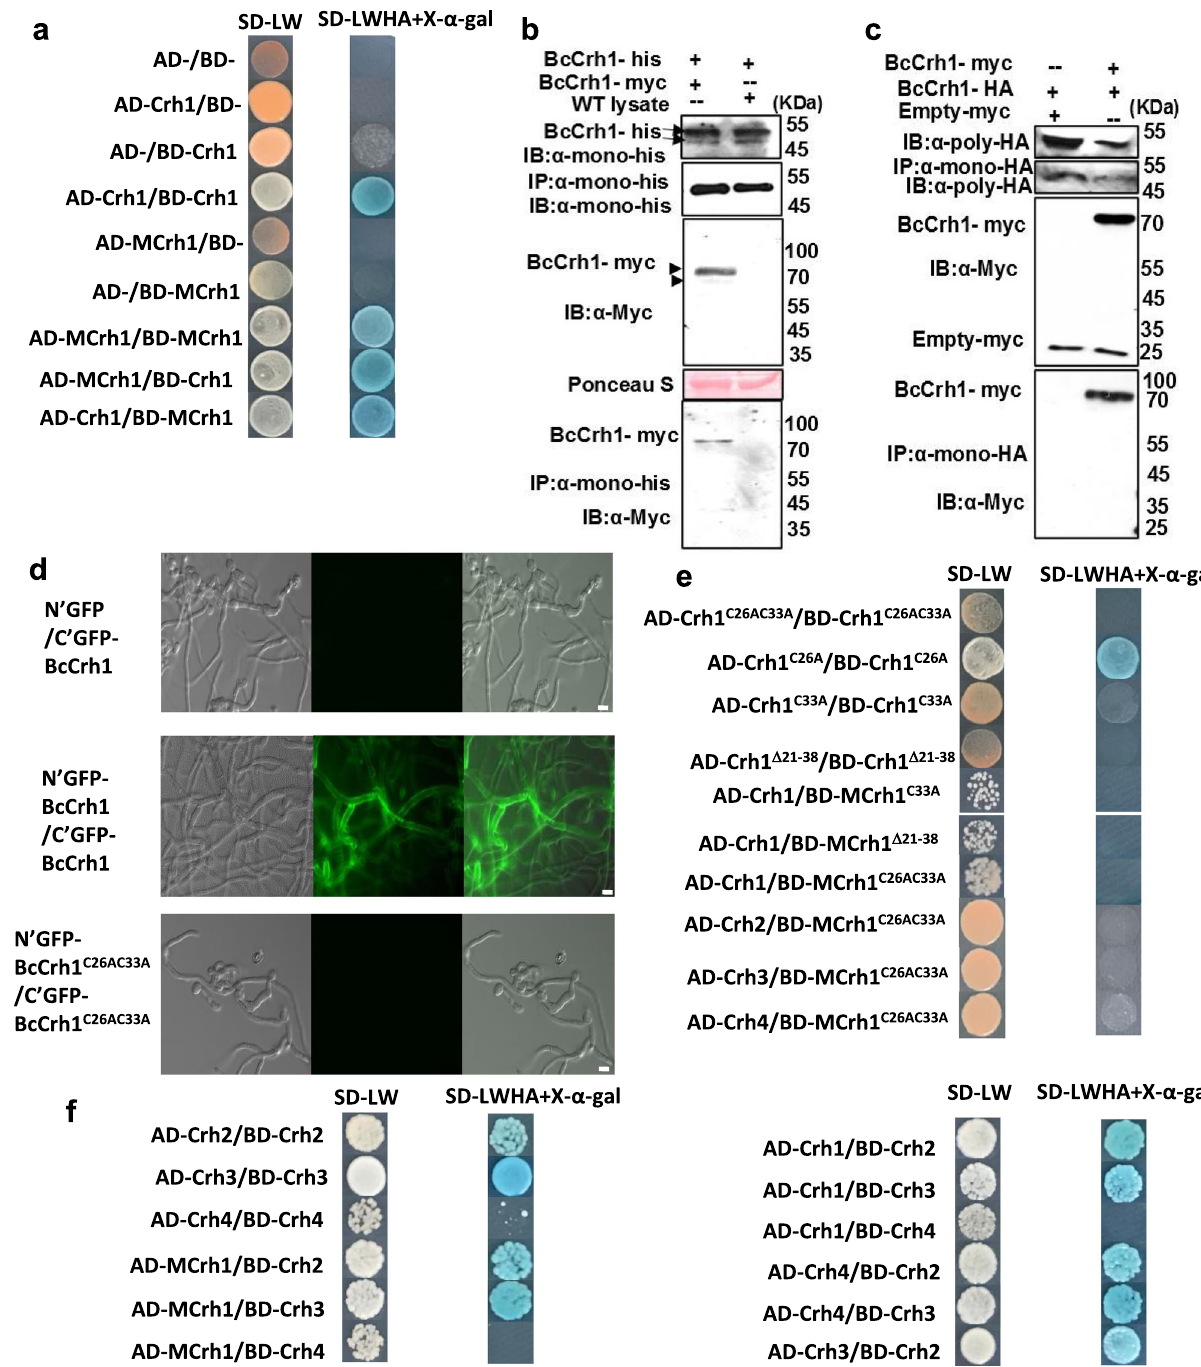
Fig. 8 BcCrh protein dimerization. a Yeast two-hybrid assay (Y2H) of BcCrh1 and MBcCrh1 homodimer formation. SD/-Trp-Leu medium was used to con fi rm the transformation events. SD/-Trp-Leu-His-Ade medium containing X- α -gal was used to screen yeast strains with the positive protein-protein interaction. b – d Con fi rmation of BcCrh1 dimer formation by in vitro pull down assay ( b ), Co-immunoprecipitation (Co-IP) assay ( c ) and bimolecular fl uorescence complementation (BiFC) assay ( d ). b For the in vitro pull-down assay, BcCrh1-myc was transiently expressed in N. benthamiana and pull down was performed with BcCrh1-His recombinant protein conjugated with histidine beads. Protein from non-in fi ltrated leaves (WT lysate) was used as negative control. c For the Co-IP experiment, BcCrh1-myc or empty-myc were co-expressed with the BcCrh1-HA in N. benthamiana . BcCrh1-myc, but not empty-myc, co-immuno-precipitated with BcCrh1-HA conjugated to HA beads. c BiFC was conducted with B. cinerea transgenic strain expressing split GFP-BcCrh1 proteins (N ′ GFP-BcCrh1/C ’ GFP-BcCrh1). A strain expressing split GFP fused to BcCrh1 C26AC33A (N ’ GFP-BcCrh1 C26AC33A /C ′ GFP-BcCrh1 C26AC33A ) did not show any fl uorescence, indicating a lack of dimer formation by this protein derivative. Bar = 10 μ m. The experiments were repeated three times with similar results. e Effect of point mutations or deletion at the N ’ part of BcCrh1 on homo- and heterodimer formation. f Y2H assay of interaction between different BcCrh members.